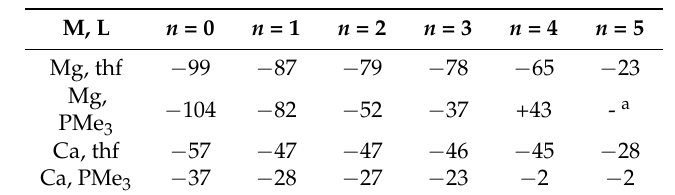
Table 1. Reaction enthalpies ∆ H (kJ · mol − 1 ) for the addition of the Lewis base L (thf, PMe 3 ) to the metal fragment [(L) n M] 2+ (M = Mg,